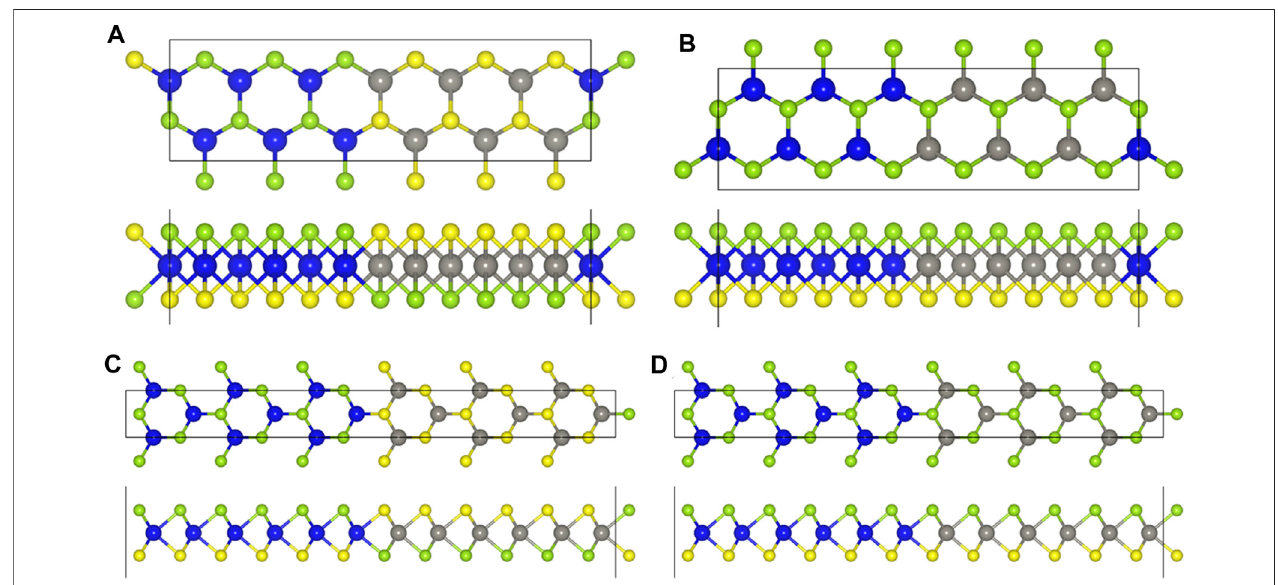
FIGURE 1 | Crystal structure of the (A) arm-1, (B) arm-2, (C) zig-1, and (D) zig-2 MoSSe/WSSe heterostructures; the blue, gray, cyan, and yellow are Mo, W, Se, and S atoms, respectively.